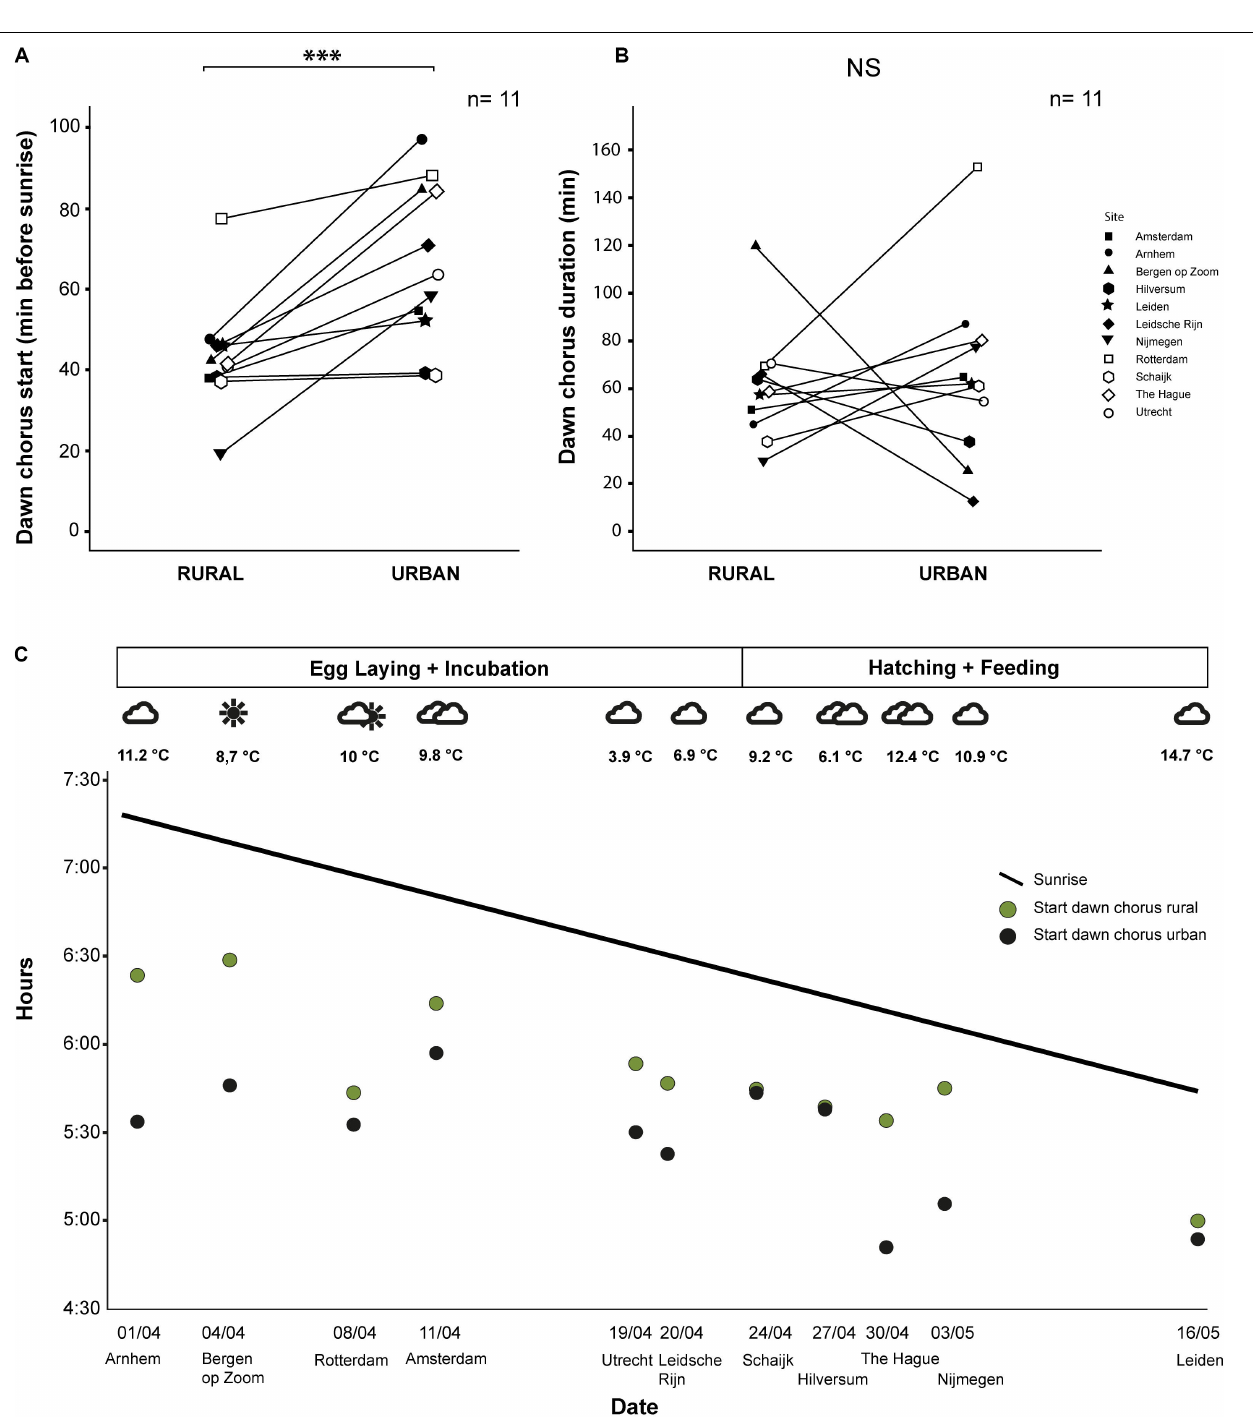
during the night and early morning than urban sites (between 00:30 and 7:30), while urban sites were relatively more noisy in the late afternoon than rural sites (between 16:30 and